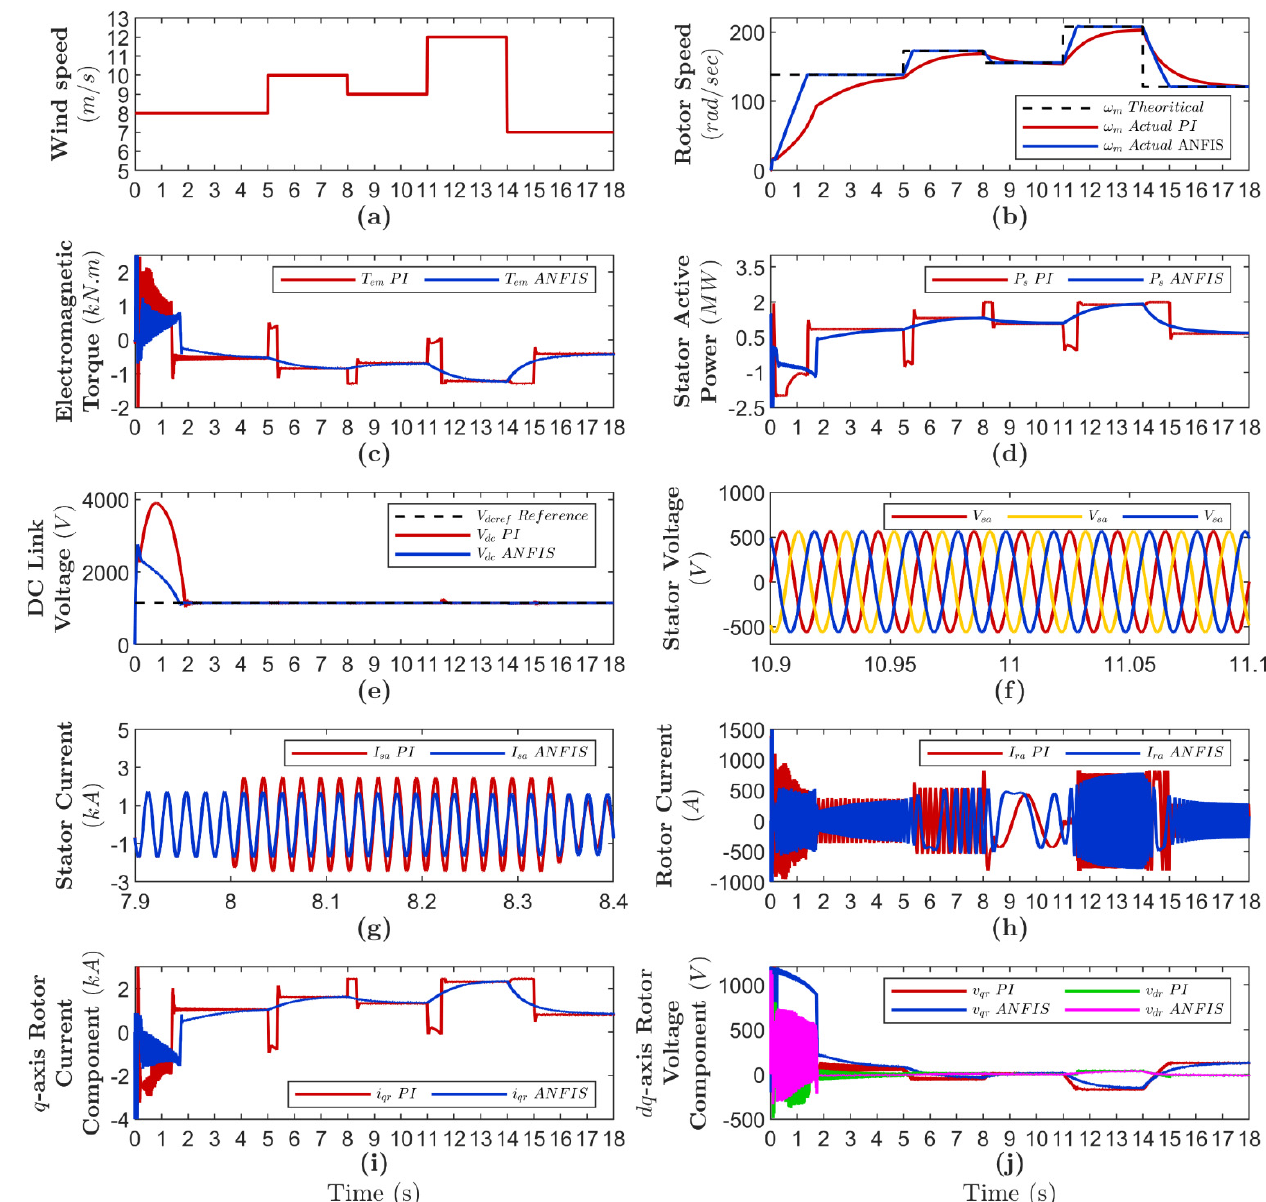
Figure 14. Simulated response under step increase wind speed: ( a ) input wind speed, ( b ) rotor speed, ( c ) electromagnetic torque, ( d ) stator active power, ( e ) DC-link voltage, ( f ) stator voltage, ( g ) stator current of a-phase, ( h ) rotor current of a-phase, ( i ) q -axis rotor current component, and ( j ) d and q axis rotor voltage component.